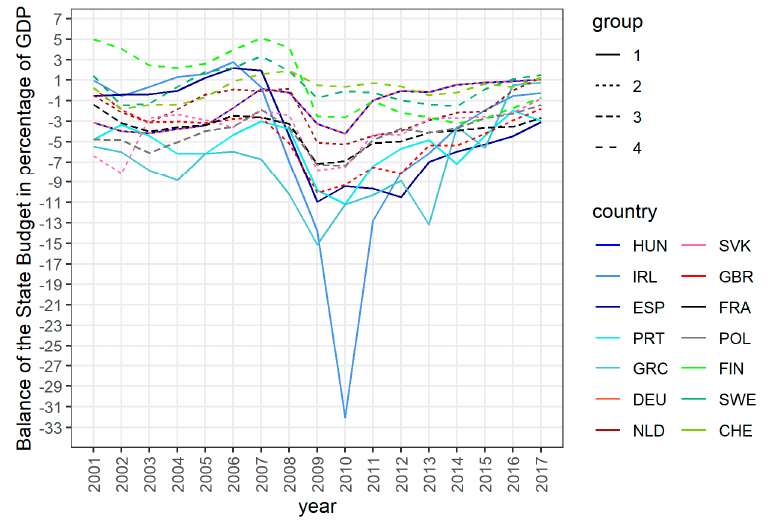
Figure 3. The balance of the deficit of state budgets in analyzed countries.